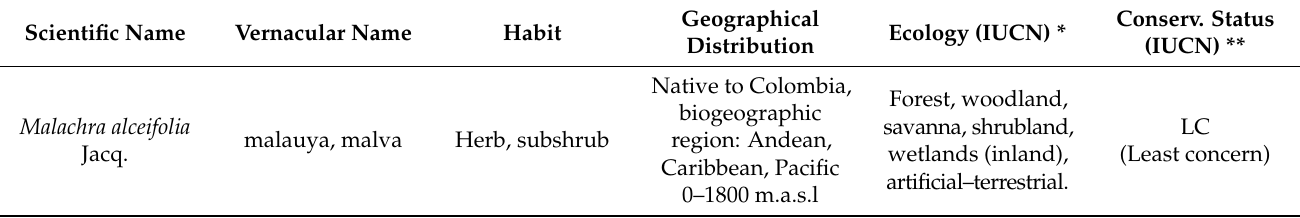
Table 4. Species of the genus Malachra L. occurring in